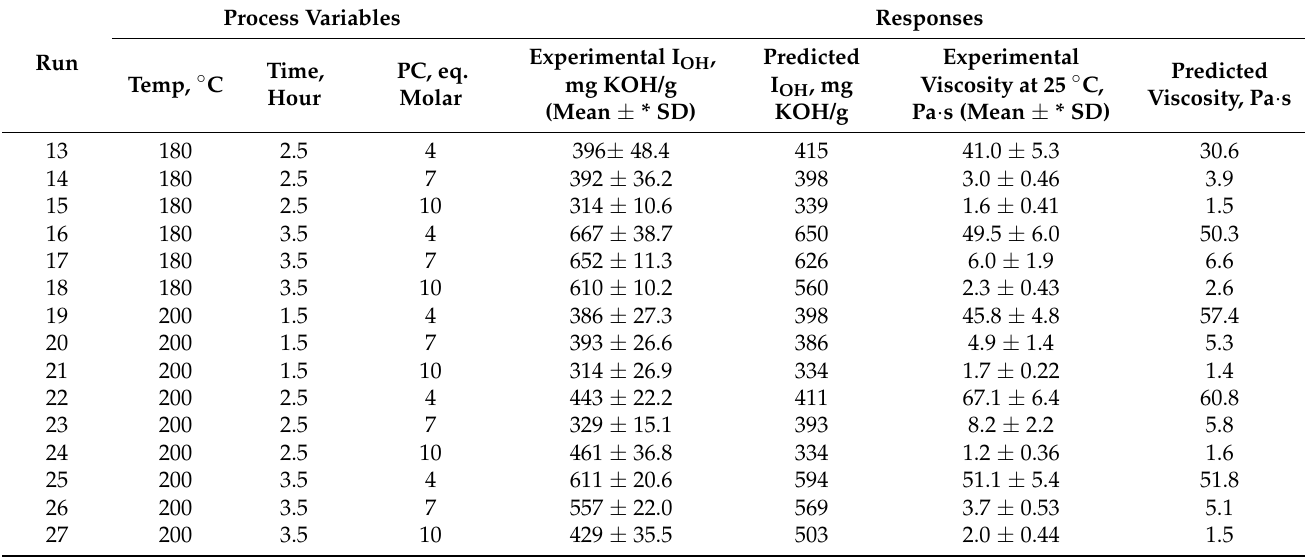
curve for the responses. For viscosity data, the fitted line plot shown in Figure 4a indicates that the experimental data fit reasonably well with the model, and the correlation coefficient (R-squared) is 0.91. However, a closer analysis reveals that the predicted values of viscosity are negative. Furthermore, the viscosity residual plot (Figure 4b) shows a distinct deviation from the usual linear model. This is a clear indication of the absence of linearity between the response and the predicted values. Indeed, it is well known that the viscosity of many materials such as polymers does not follow linear behavior but a logarithmic one [24,25]. Hence, the log values of viscosity were used instead and as can be observed in Table 2 and Figure 5b, both the experimental and predicted values follow a linear trend.